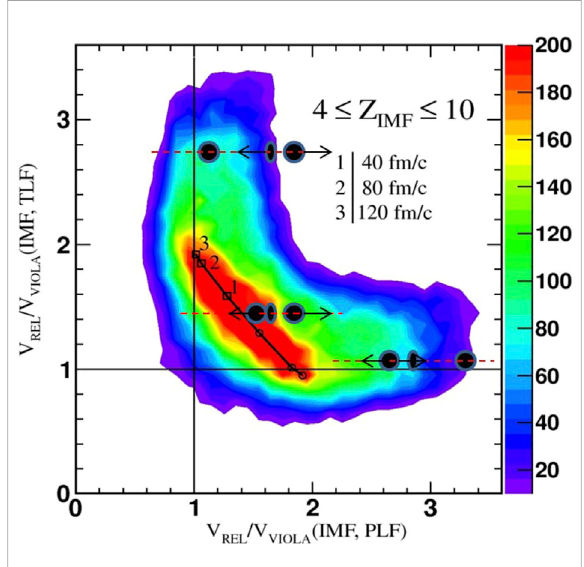
FIGURE 2 WILC2-Plot relative velocity correlations for semi-peripheral collisions in the reaction 64 Ni + 124 Sn at the beam energy of 35 MeV/nucleon. The labels 1, 2, and 3 indicate chronological steps of different emission times of fragments from the prompt emission (40 fm/c) to a more delayed emission ( > 120 fm/ c). The time chronology has been evaluated by Wilczynski et al. (20, 24) under the assumption of a sequential two-step